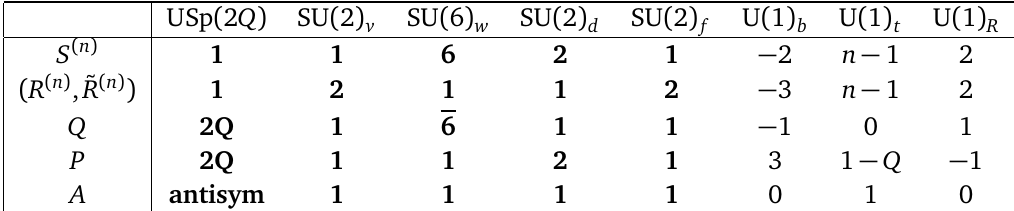
× SU ( 2 ) 2 × U ( 1 ) 2 model and their 6